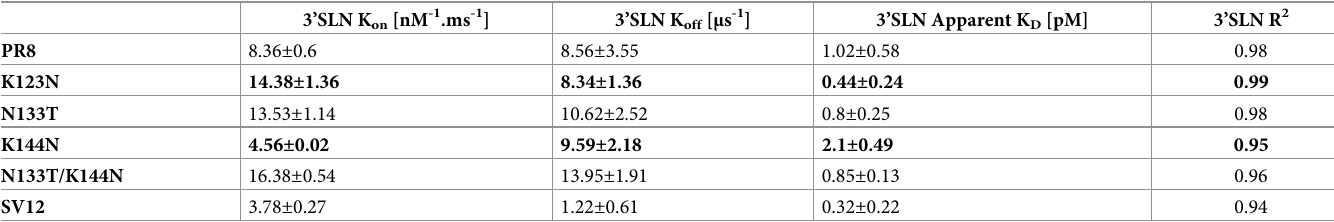
Table 1. Bio-layer interferometry analysis of HA compensatory